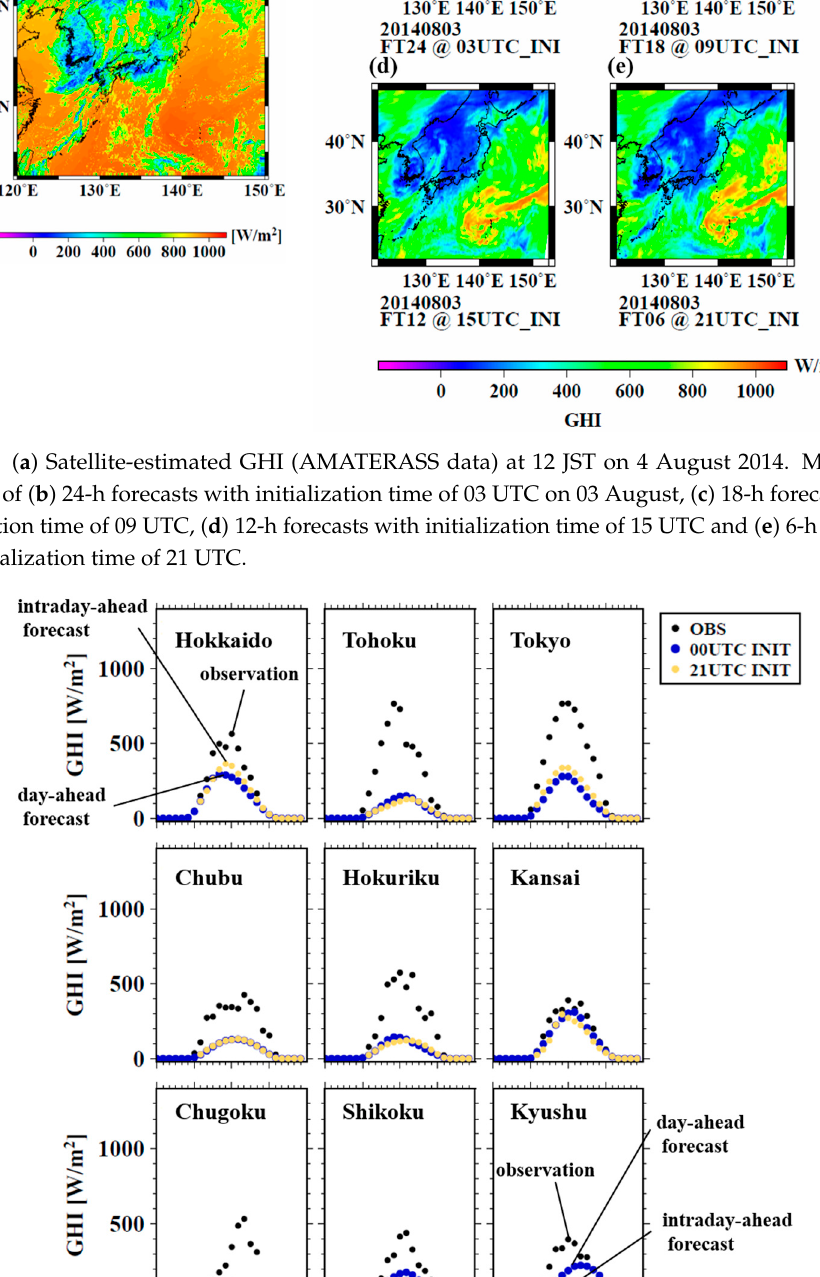
Figure 4. Time series of regionally integrated GHI observations and forecasts for nine electric power